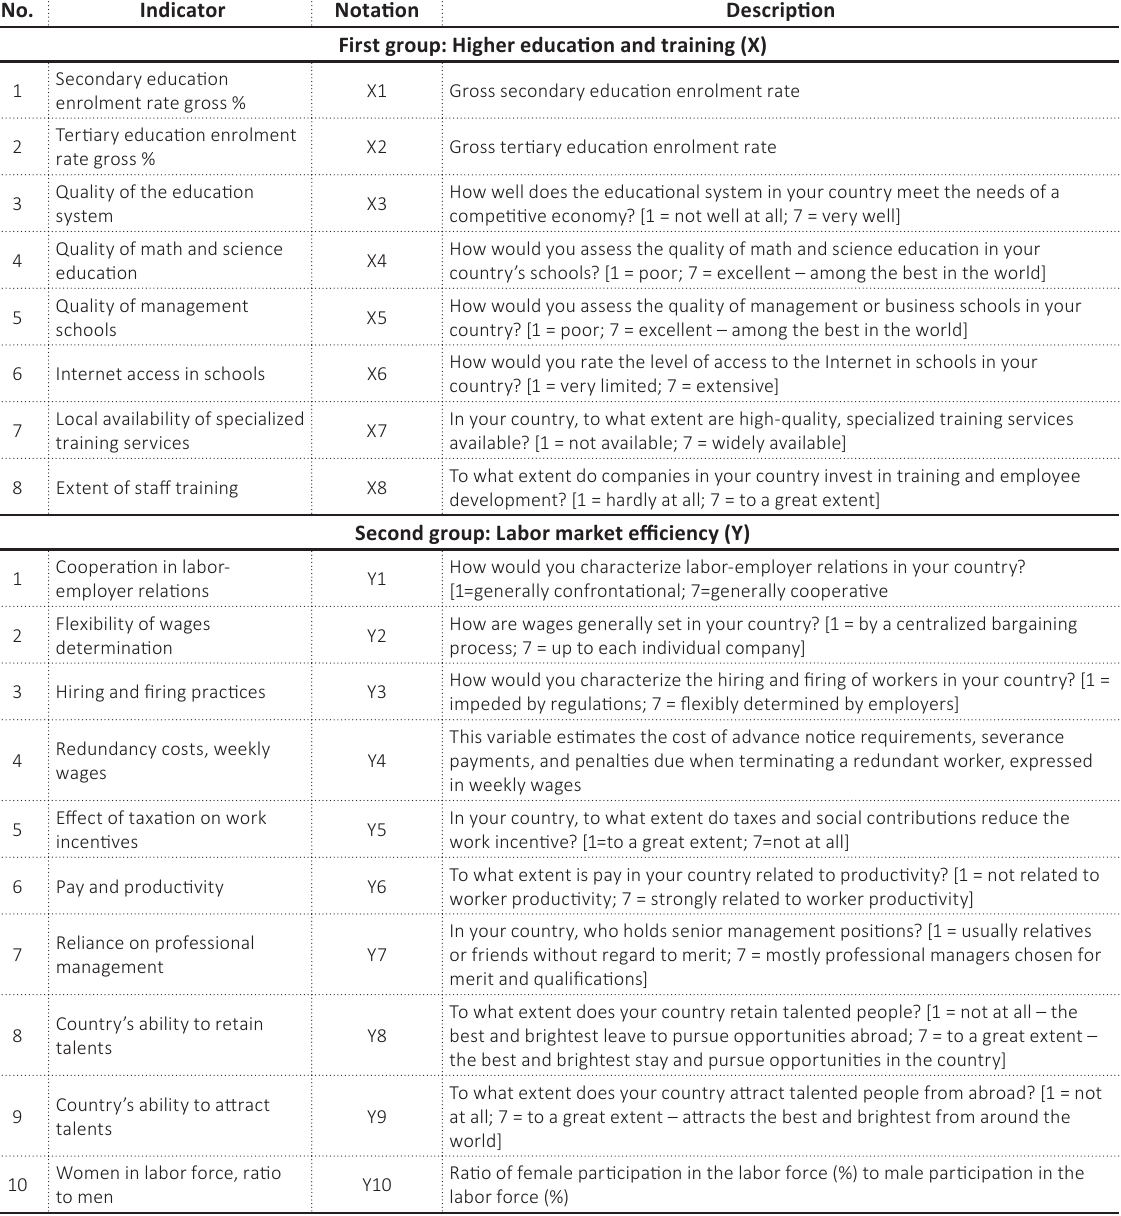
Table 1. Higher education and training and labor market efficiency factors and their indicators No.